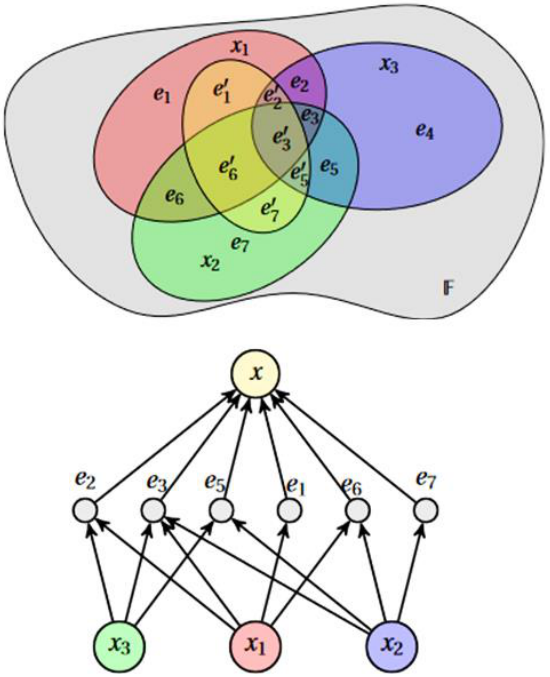
Figure 1. HCBR models a dataset as a hypergraph in which each vector (case) is an edge. The partition of cases forms a tribe on which probabilistic modeling is based. x i denotes a case and e i one element of the case partition.